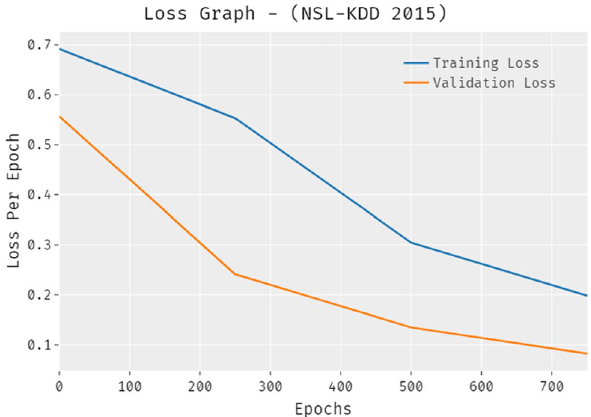
Figure 8. Loss analysis of PRO-DLBIDCPS technique NSL-KDD-2015 dataset.